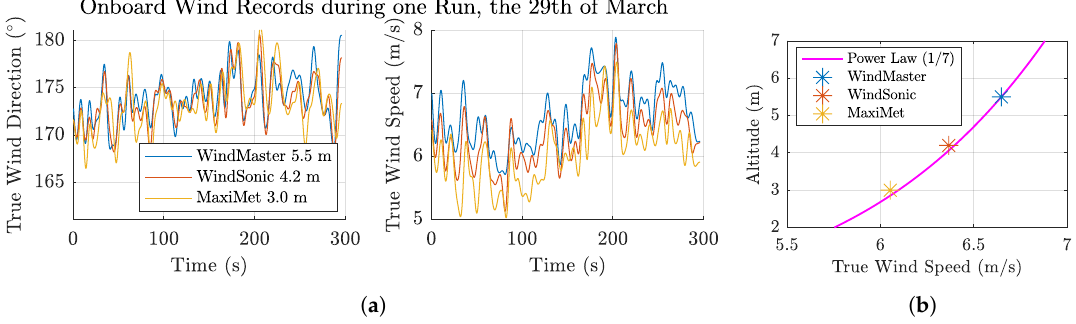
Figure 12. Comparison between the wind measurements of the three on-board sensors ( a ). The average value of the true wind speed during the run is plotted for each one ( b ), and compared to the power law calculated from the WindMaster measurement at 5.5